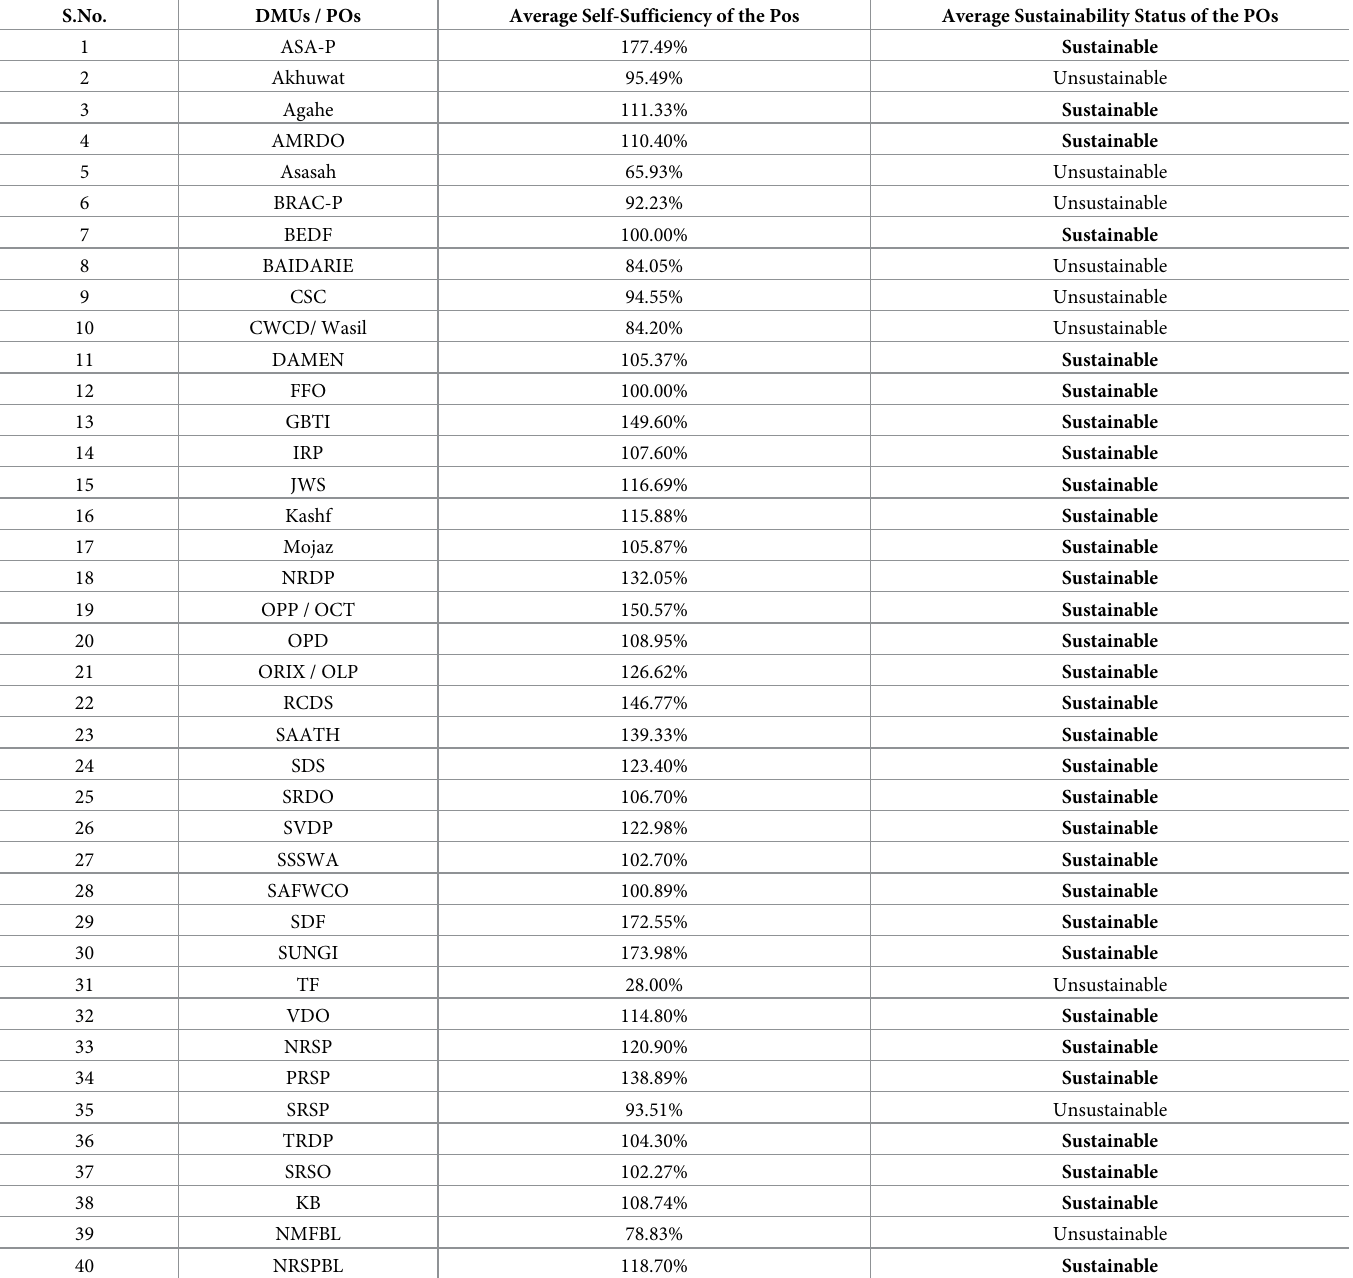
Table 6. Average suitability status of Pakistan Poverty Alleviation Fund’s partner organizations.